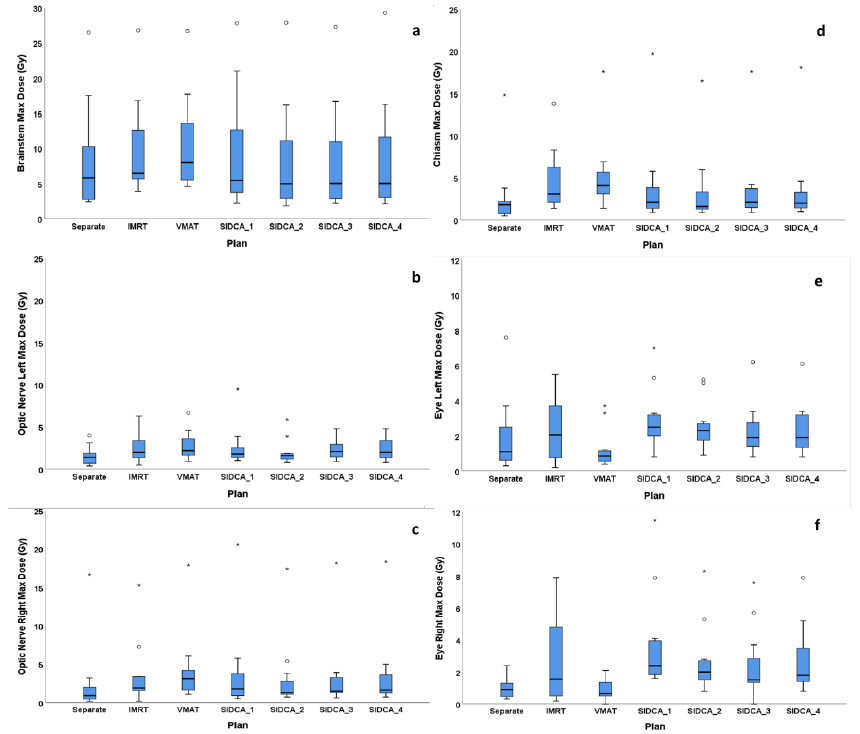
Figure 4. The boxplots of the maximum dose to brain stem ( a ), optic nerves (left b , right c ), chiasm ( d ), and eyes (left ( e ), right ( f )) as a function of different plans. * For all patients and all plans, the maximum doses to OARs were within our limits and thus clinically acceptable, but varied between treatment